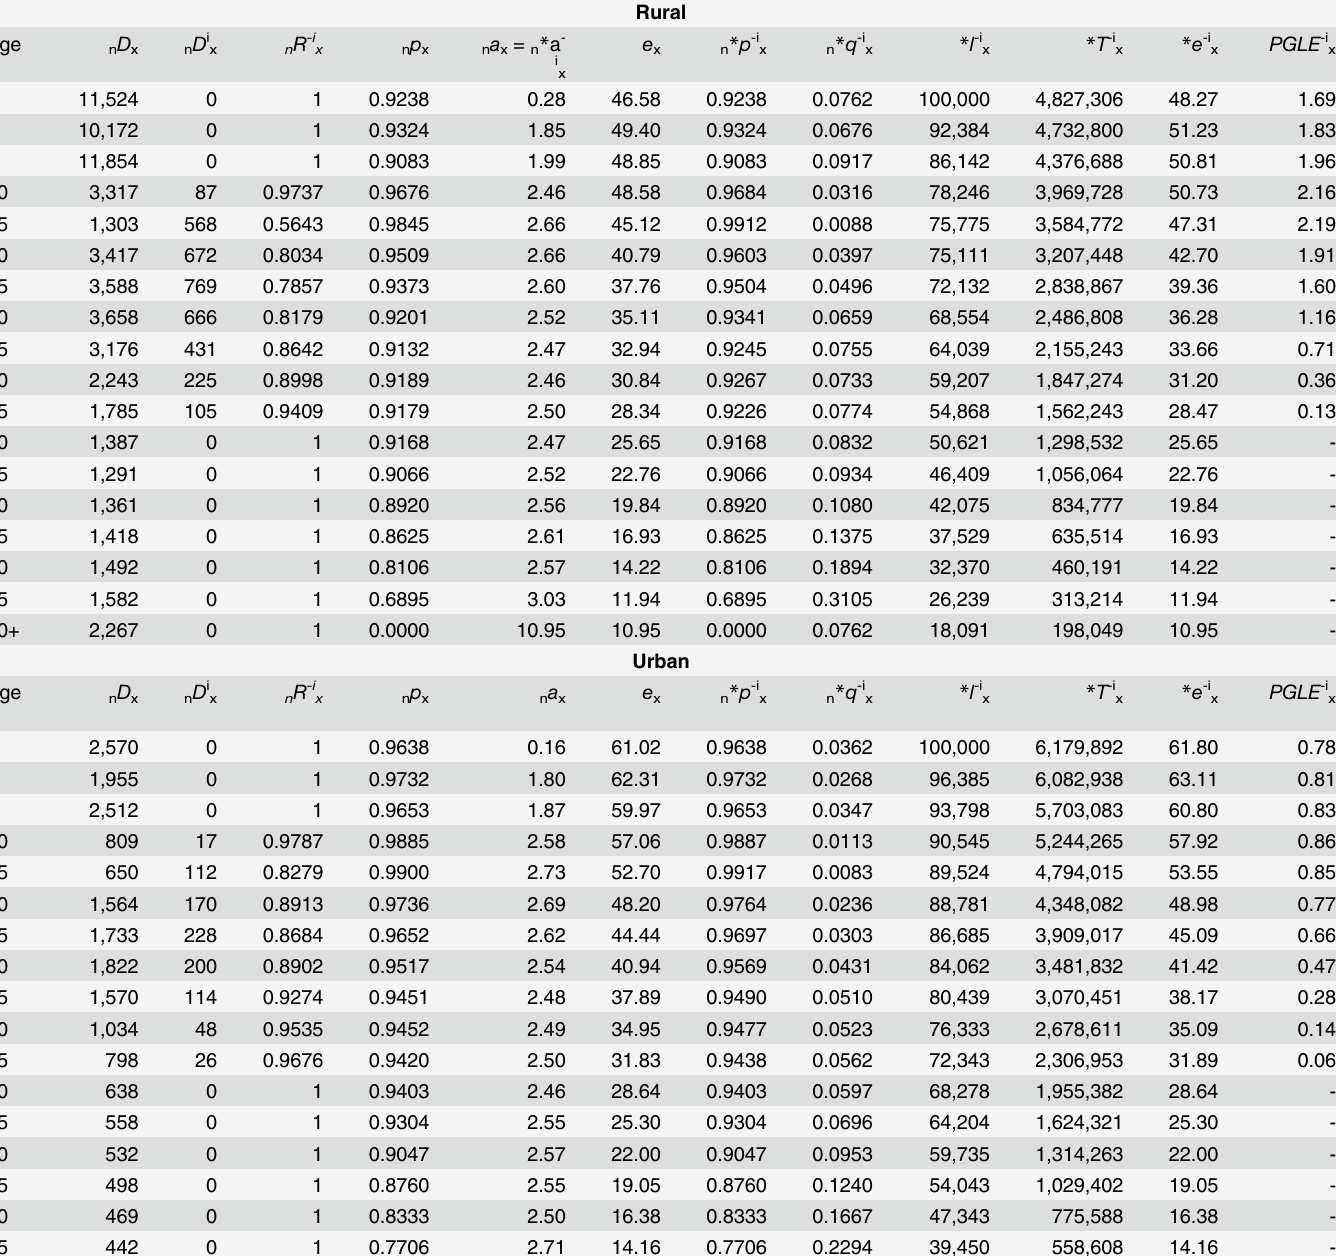
Table 2. Abridged associated single decrement life tables (ASDTs), assuming full elimination of pregnancy-related mortality (i) females only, Zam- bia 2010, by rural-urban residence